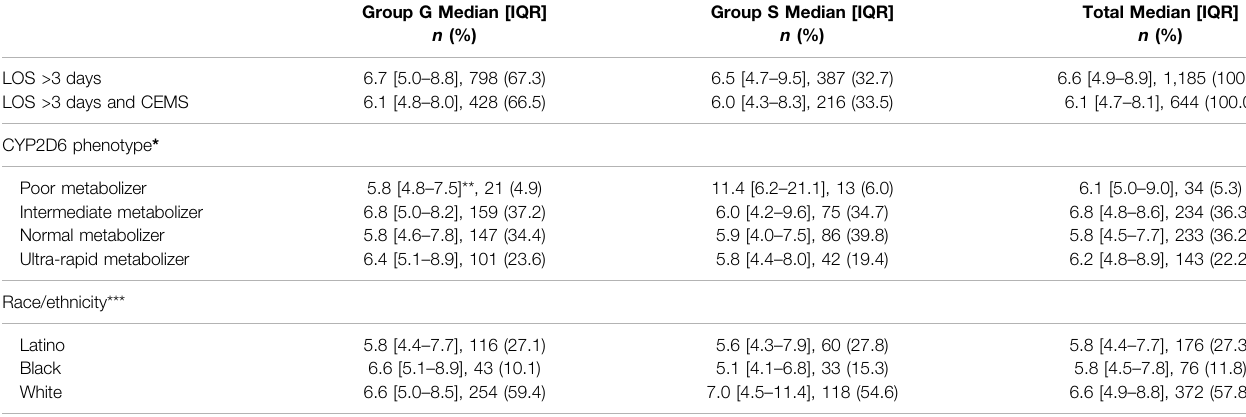
TABLE 2 | Length of Stay strati fi ed by Groups G and S according to CYP2D6 phenotype and race/ethnicity.